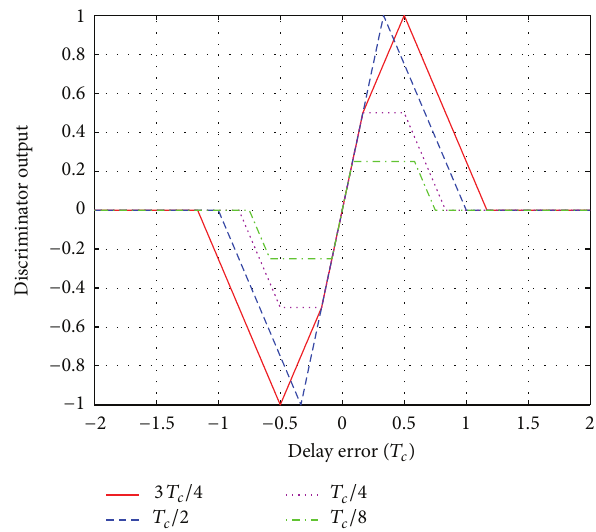
Figure 5: Characteristics of the